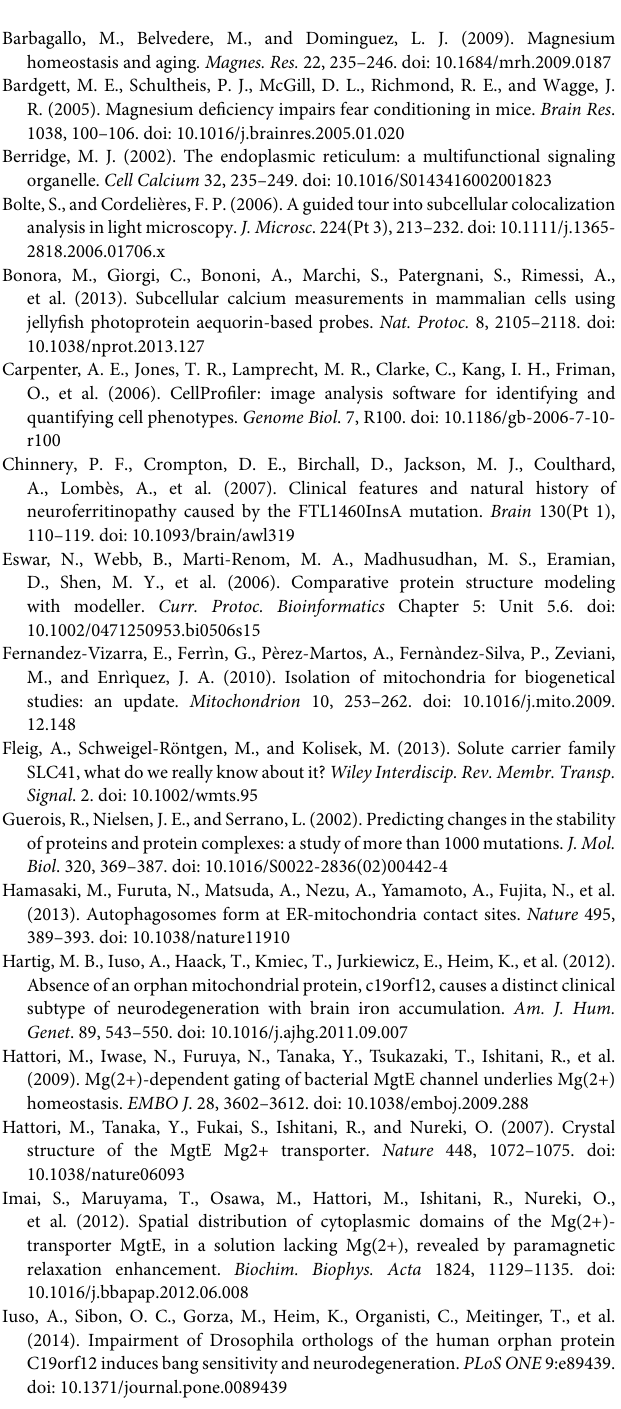
(iii) colocalization signal (yellow). Multiple orthogonal view of the merged signal are displayed and marked by sequential numbering. (iv) Percentage of C19orf12-mKate2 aggregates colocalizing with LC3 vescicles (v) LC3 puncta co-localizing with mKate2 aggregates (cross, average; line, median; box, 25 and 75 percentile; bars, max and min value, n = 12 ).